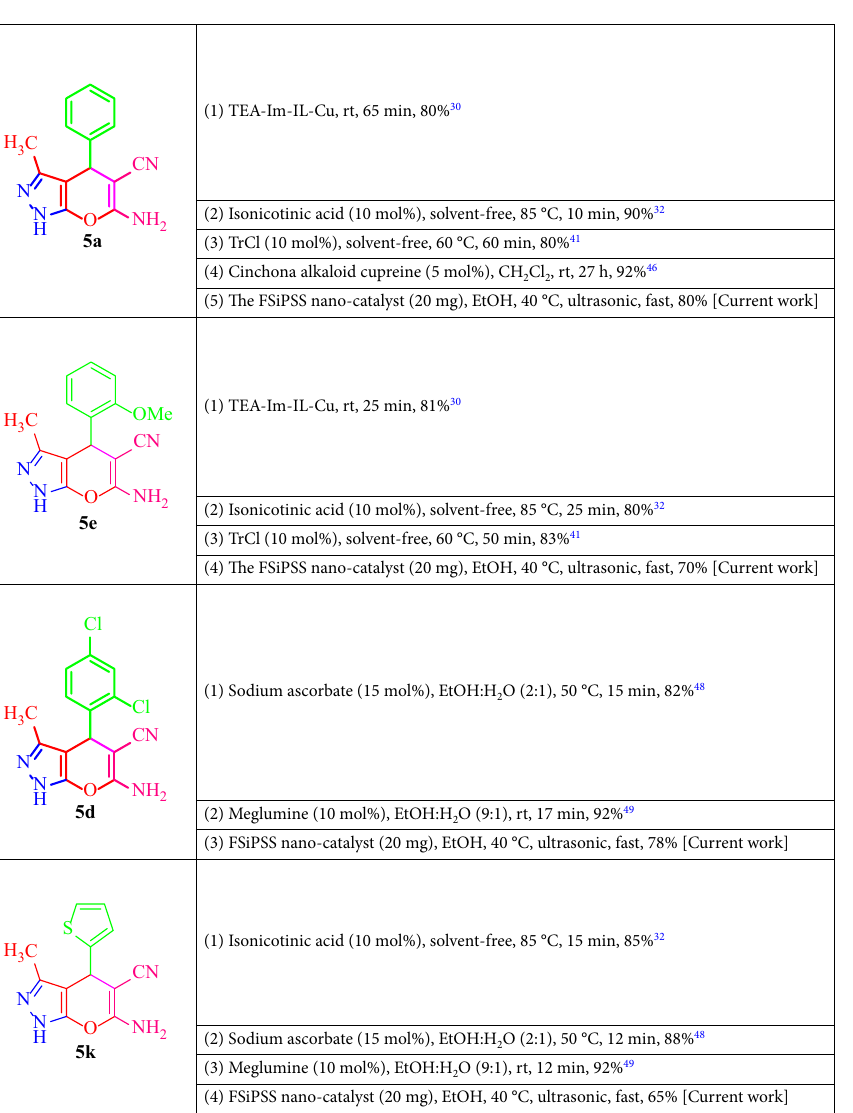
Table 6. Comparison of the prepared catalyst with other reported